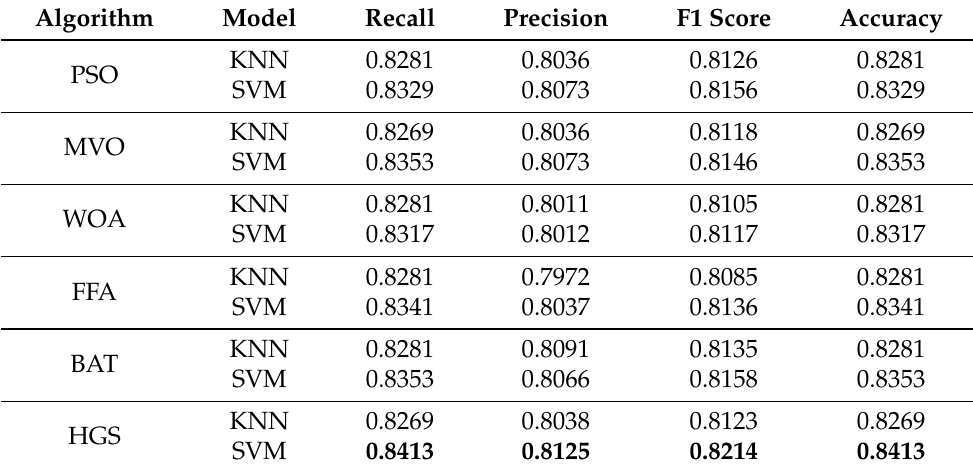
Table 6. Results of each algorithms on MAVEN